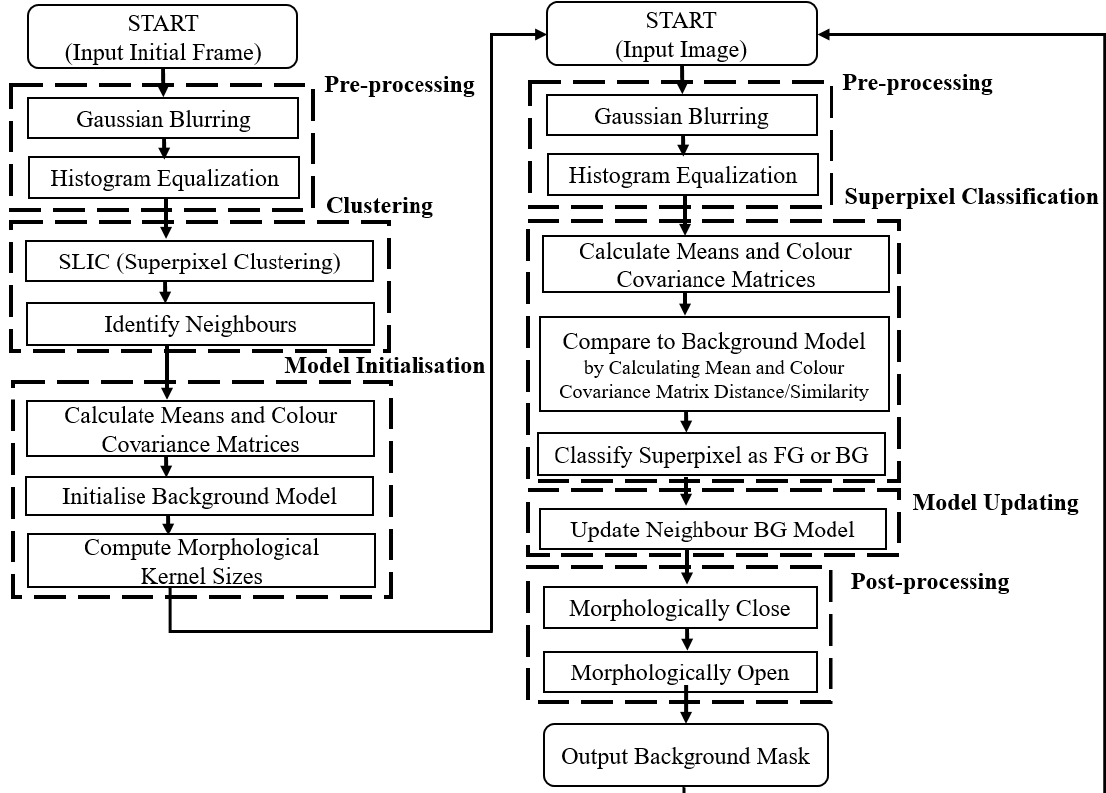
Figure 3. Flowcharts showing the background model initialisation ( left ) and frame masking ( right ) processes of SuperBE